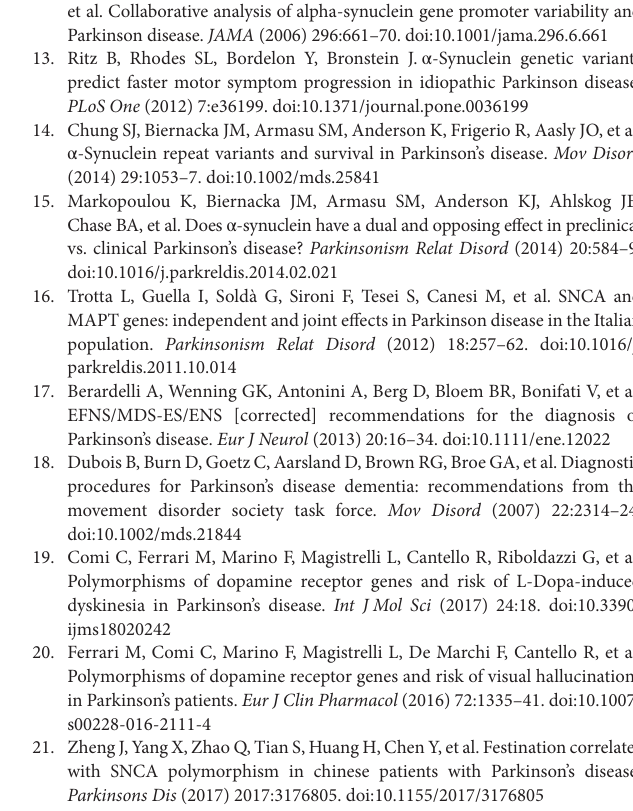
TaBle s1 | Genotype distribution